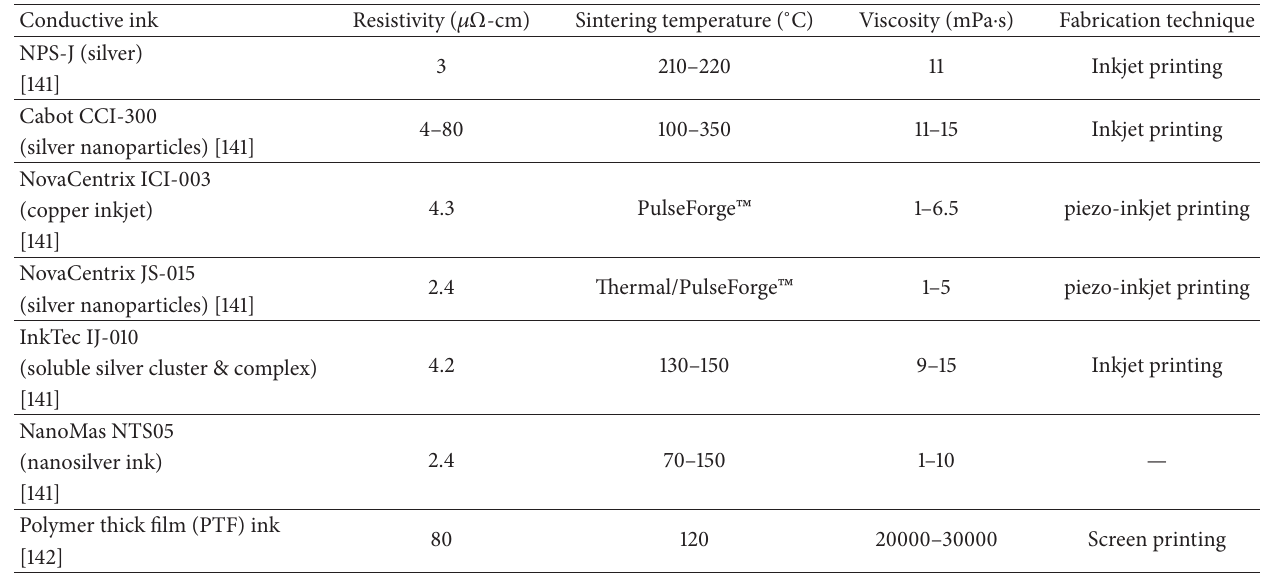
Table 4: Conductive inks characteristics.